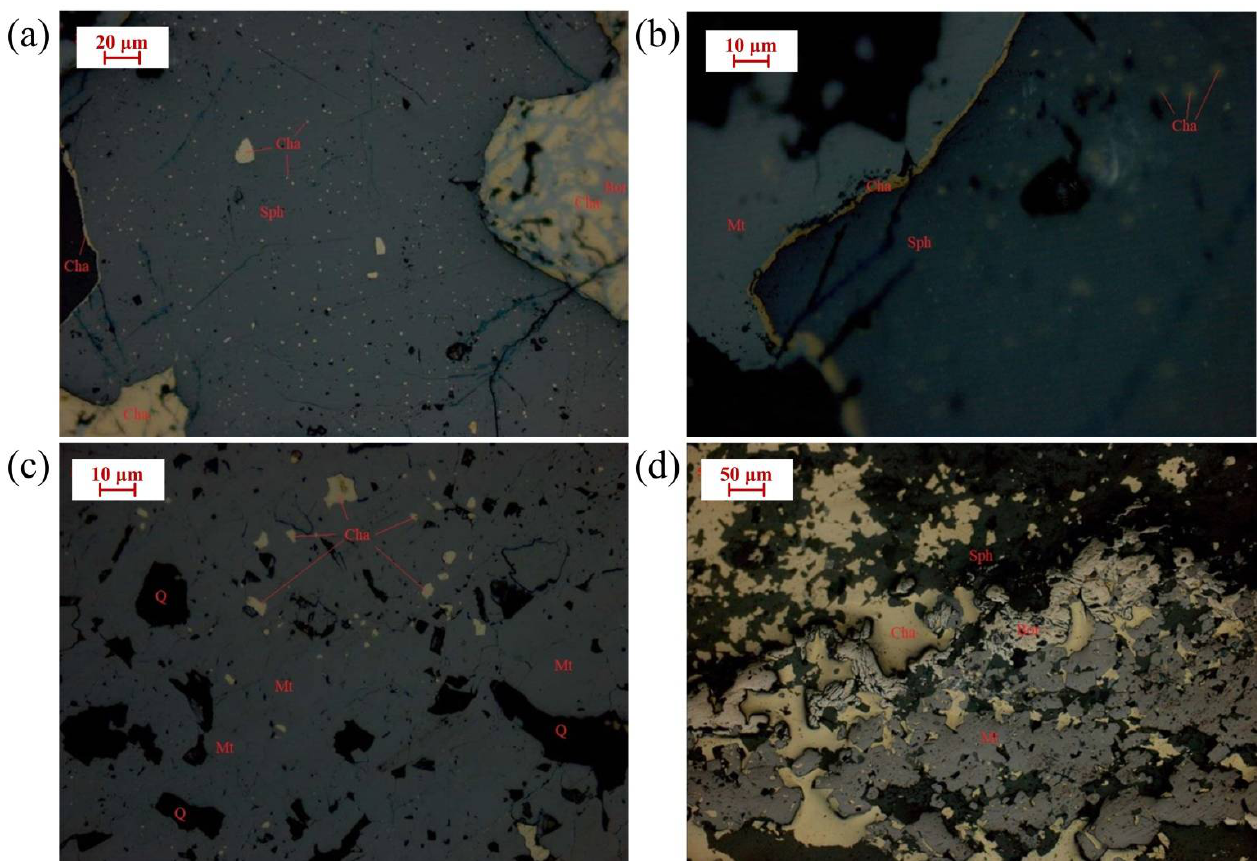
Figure 3. Association and dissemination properties of the main minerals. (Cha-chalcopyrite, Sph-sphalerite, Mt-magnetite, Q-quartz. ( a ) Chalcopyrite was distributed in sphalerite; ( b ) Chalcopyrite contacted with magnetite and sphalerite; ( c ) Chalcopyrite was distributed in magnetite; ( d ) Chalcopyrite contacted with magnetite).